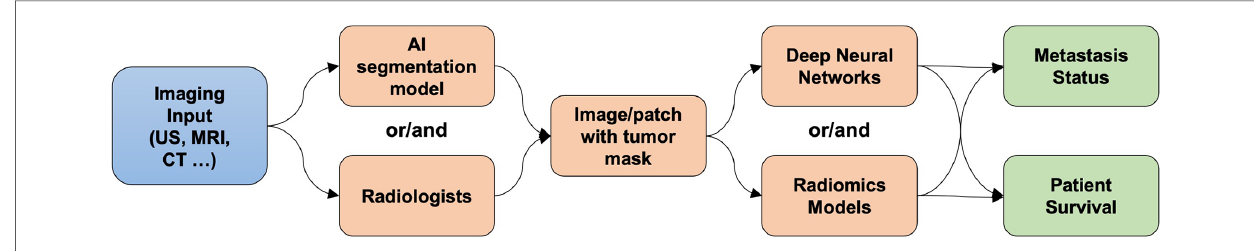
FIGURE 1 Example work fl ow illustrating AI analysis in identifying axillary lymph node